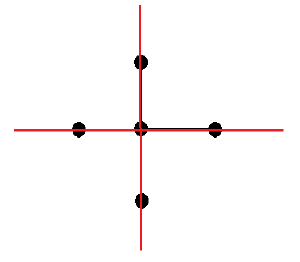
Figure 3. Geometrical symmetry: horizontal and vertical axis indicated by red